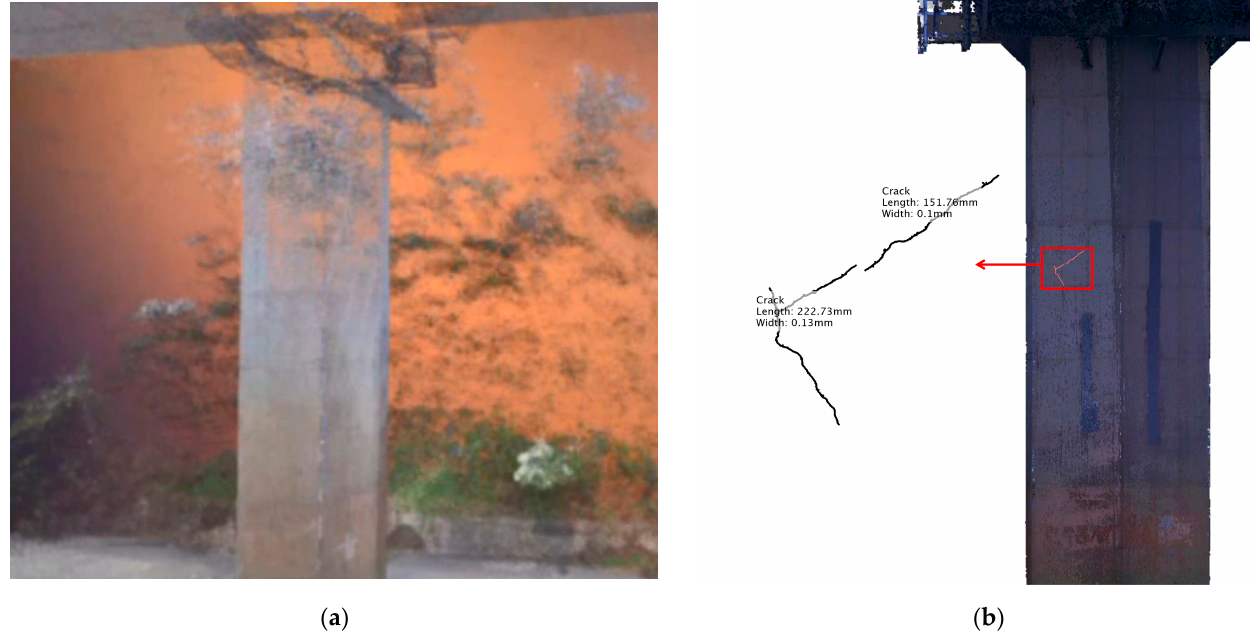
Figure 6. Scan-to-BIM model: ( a ) point cloud model generated using the photogrammetry algorithm using digital images acquired by a digital camera embedded on a UAV; ( b ) texture- and damage-mapped BIM model.